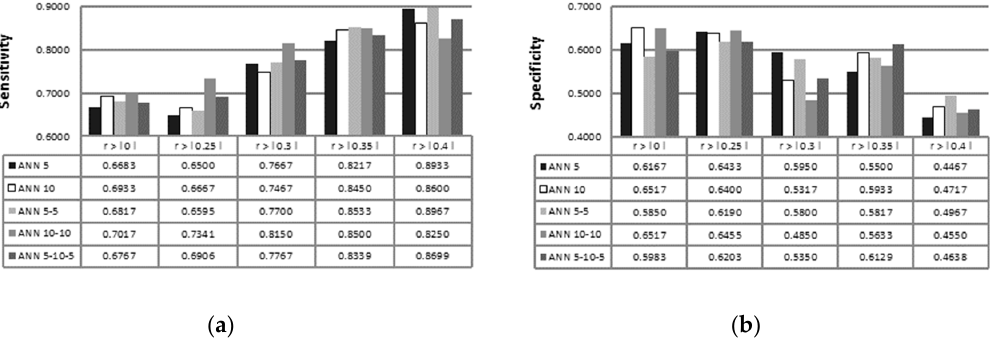
Figure 3. Sensitivity (a) and specificity (b) measures of ANN 5, ANN 10, ANN 5-5, ANN 10-10, and ANN 5-10-5 configurations with Pearson’s-based feature selection.